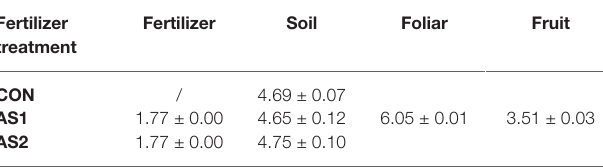
TABLE 2 | pH of fertilizer, soil, foliar, and blueberry fruit samples in 2017–2018. Fertilizer